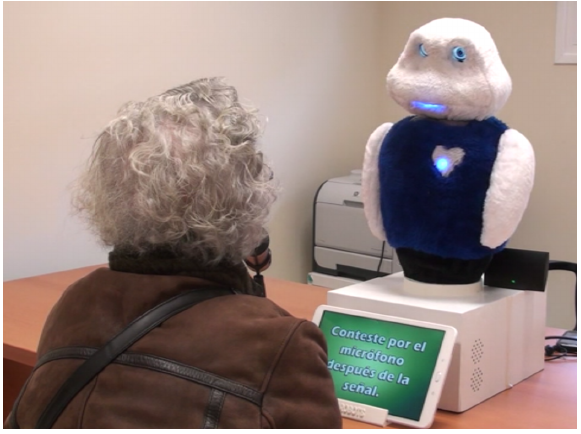
Figure 8. An older adult interacting with